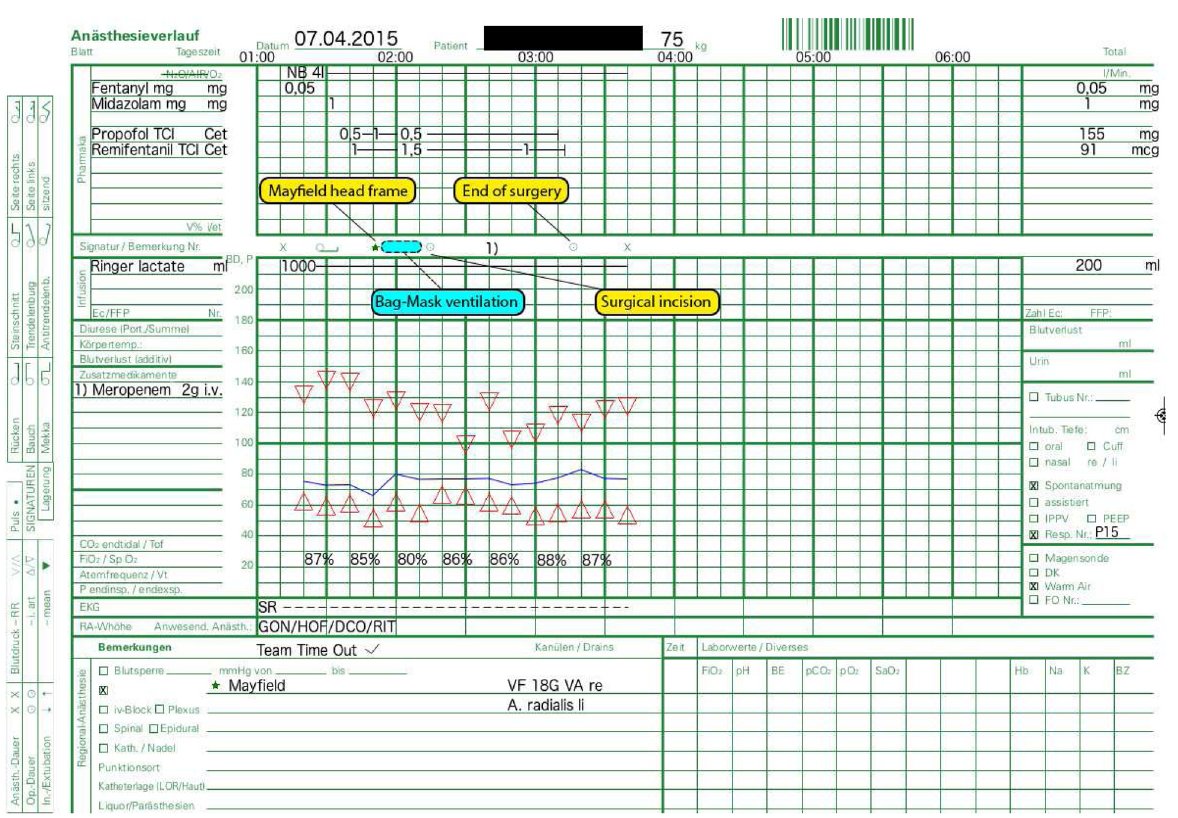
Figure 3. Intraoperative anesthesia record. For fixation of the patient’s head in the Mayfield frame, the target effect-site concentration (Cet) of propofol was temporarily increased to 1.0 µg ml -1 . Due to a subsequent brief loss of consciousness with upper airway obstruction, a short period of assisted bag-mask ventilation was performed. Adequate spontaneous respiration returned after the patient regained consciousness and was maintained throughout the procedure with supplemental oxygen delivery at 4 l min -1 via nasal prongs (NB). Propofol and remifentanil infusions were adjusted to the patient’s clinical level of sedation and pain and bispectral index monitoring. During surgery, the patient remained in cardiac sinus rhythm (SR) and hemodynamically stable without any need for vasopressor